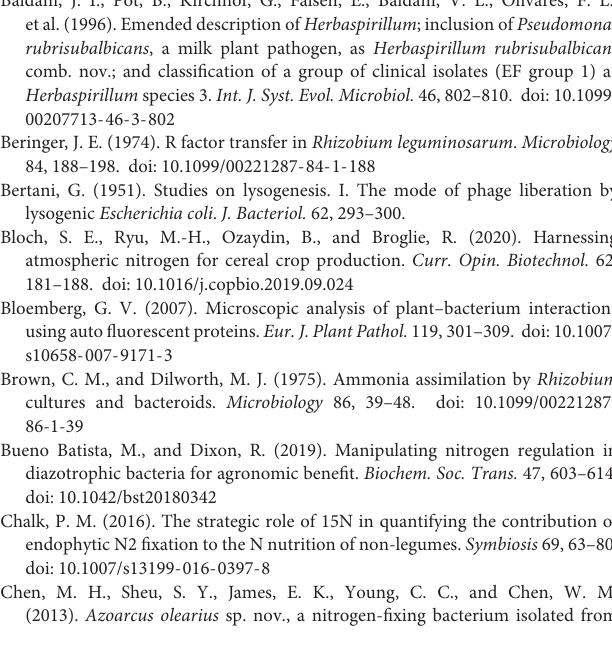
Supplementary Figure 1 | Construction of strain Ac LP. To construct Ac LP, a 282-bp region of genomic DNA adjacent to glmS comprising the Rhizobium leguminosarum biovar viceae 3841 Tn 7 attB site was amplified and assembled with 1-kb flanking regions of DNA amplified from a harbor site in the Ac chromosome into pK19mobSacB, creating plasmid pOPS1475. Plasmid pOPS1475 was introduced into Ac and sucrose selection was used stably